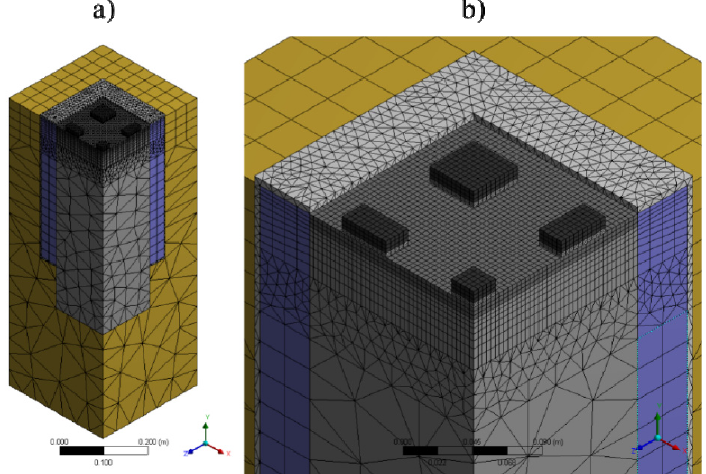
Figure 6. ( a ) Domain of the finite element model used to predict the annual production of the STEG; ( b ) detail of the mesh.